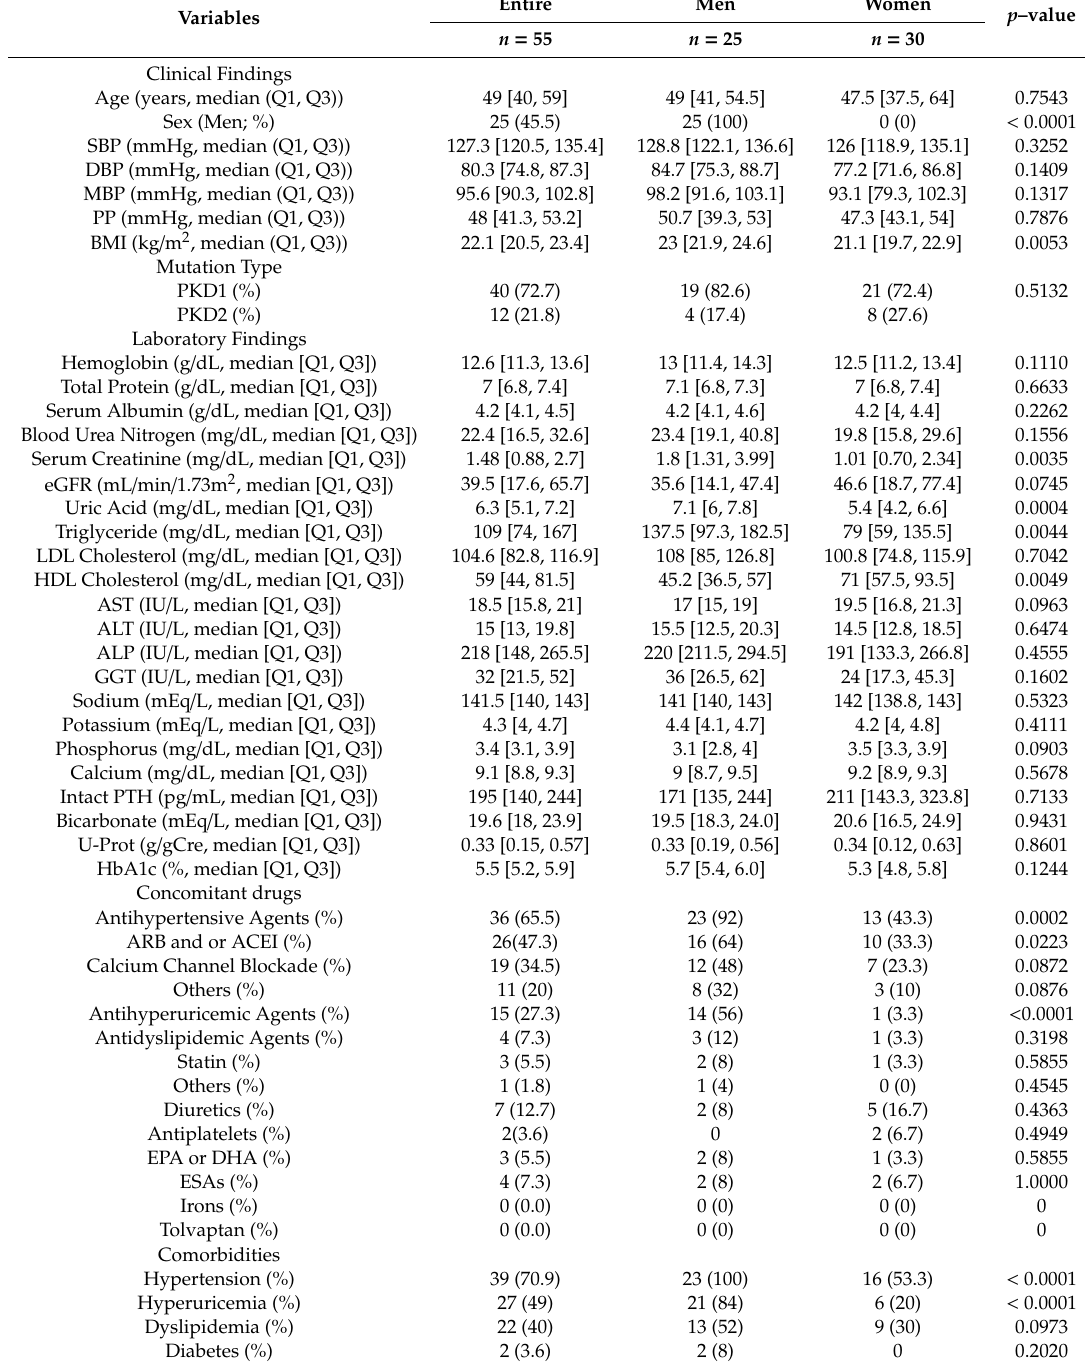
Table 1. Patient baseline characteristics according to sex ( n =